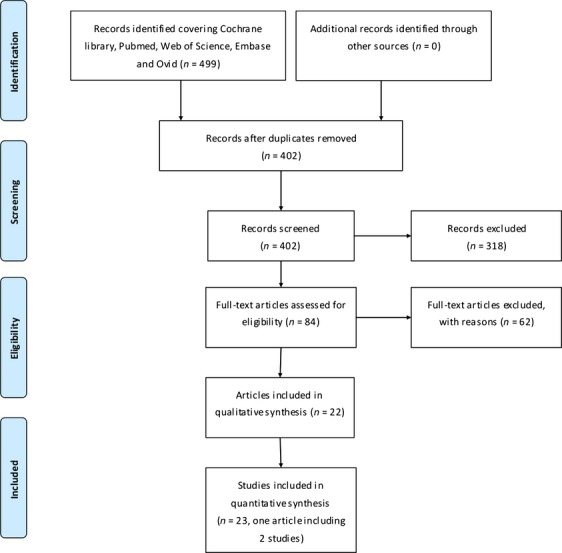
Flow diagram of the literature retrieval.